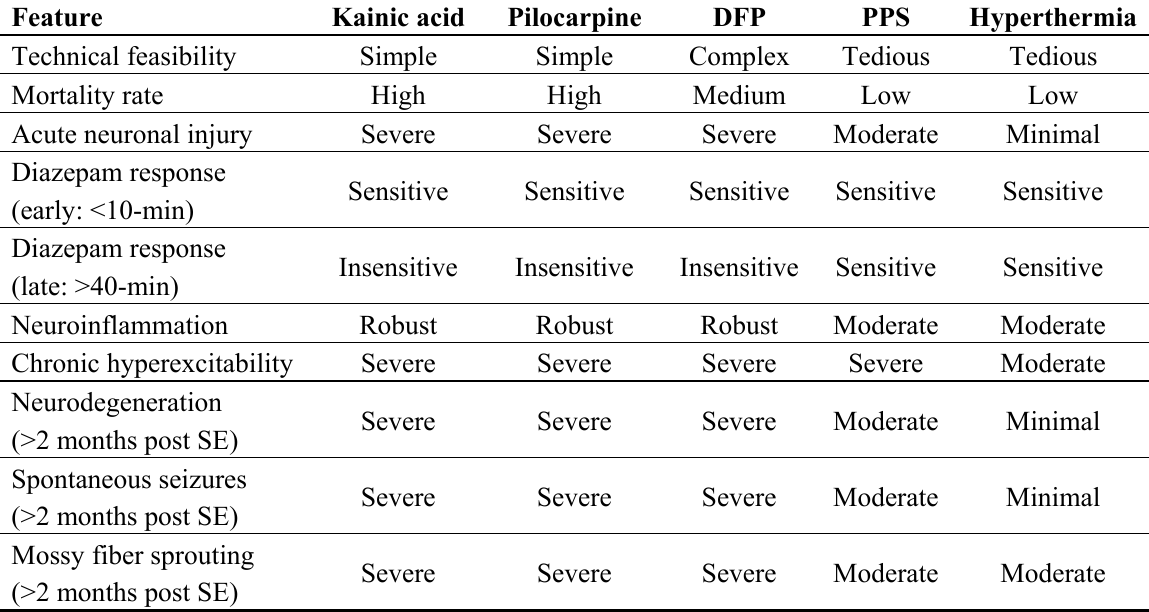
Table 3. General profiles of selected animal models of